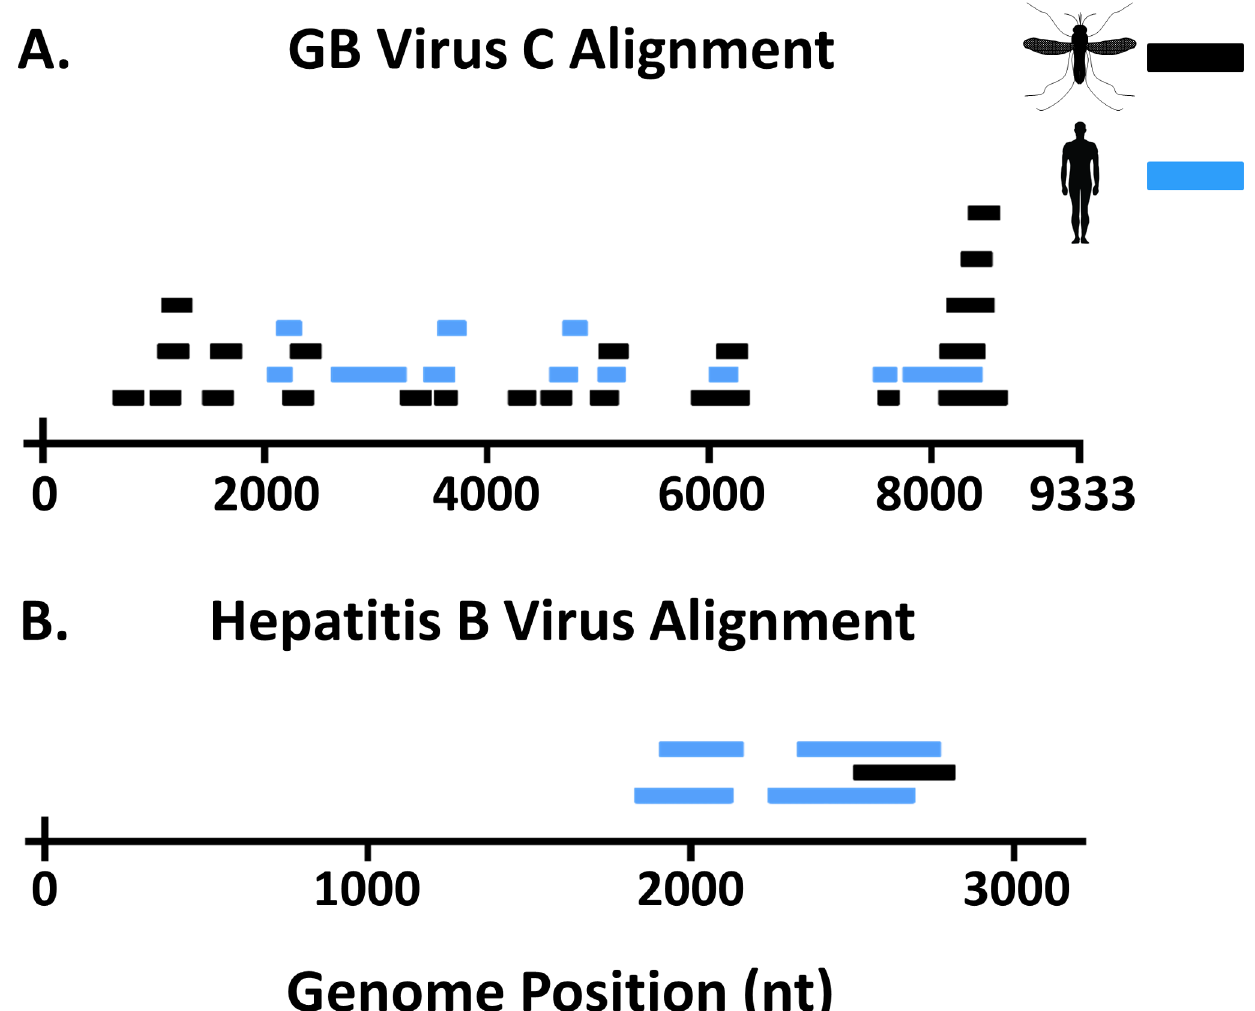
Fig 3. H and M-DBS showed reads aligning to human viruses at similar levels. A) RNA sequencing revealed multiple reads from pools of both H and M-DBS spanning the GB virus C genome. B) Hepatitis B virus reads were discovered from DNA sequencing pools of both H and M-DBS. For both viruses, reads from M-DBS were comparable in quantity and quality to reads from